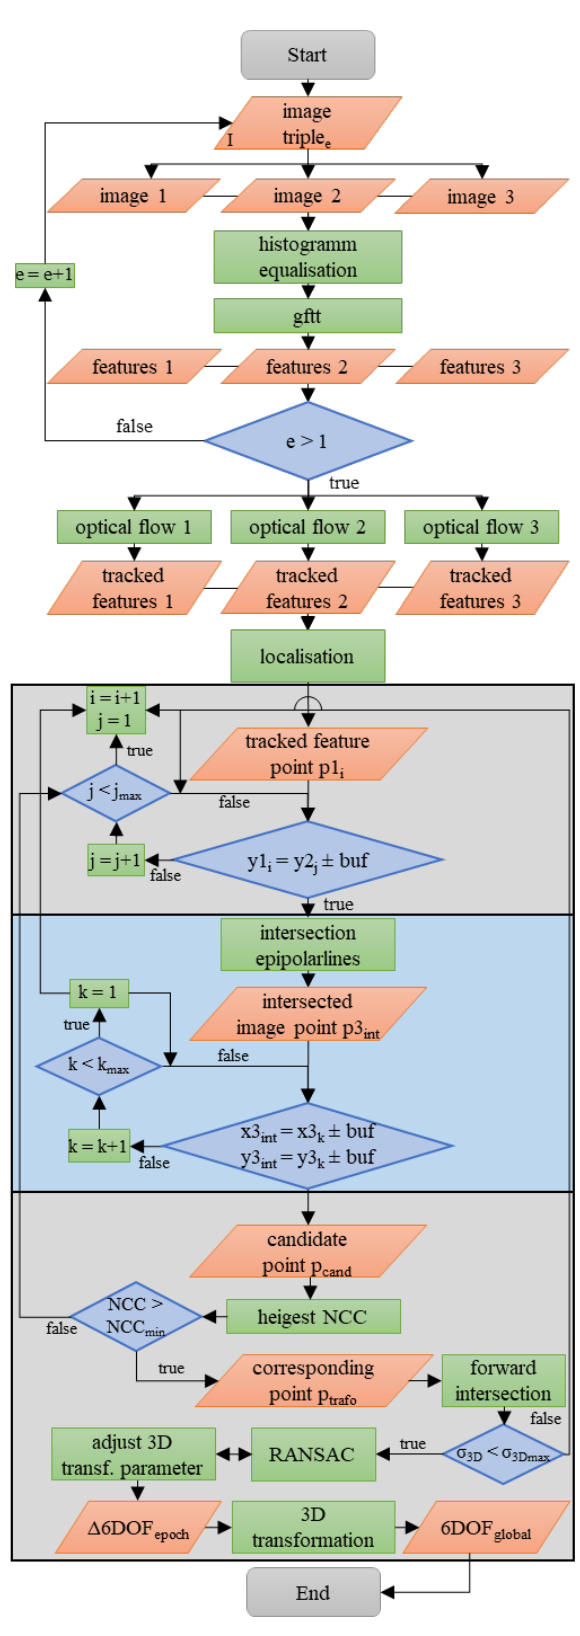
Figure 2. Flowchart of trinocular visual odometry algorithm. The part of the localisation is highlighted in grey. The part with blue background is applied when trinocular VO is conducted. In stereo VO this part is skipped, since only two images are